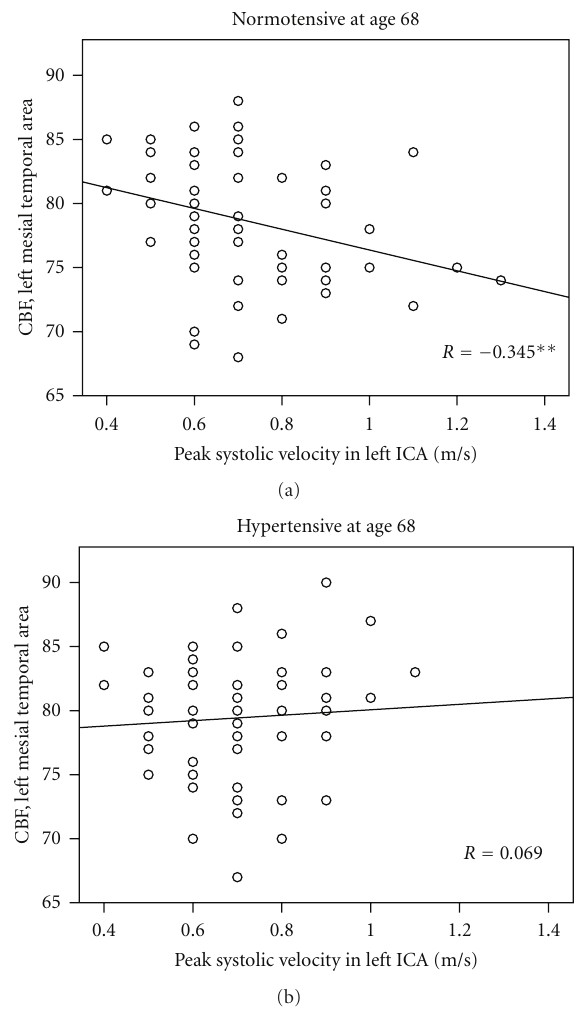
Figure 3: Distribution of cerebral blood flow values (CBF), esti- mated in left mesial temporal area, depending on the level of peak systolic Velocity in left internal carotid artery (ICA). scatter pre- sented for both normotensive and hypertensive subjects at age 68.